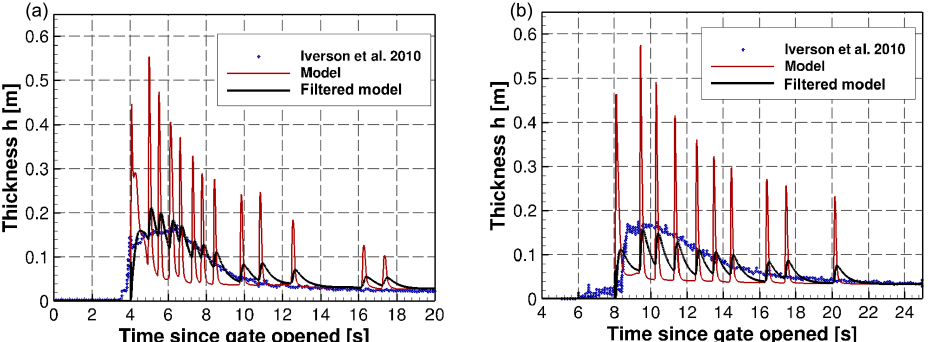
Figure B8. Comparison of the flow thickness measured in the experiment of Iverson et al. (2010) and computed with our model. Flow thickness at two locations: (a) 32m and (b) 66m downslope from the gate.